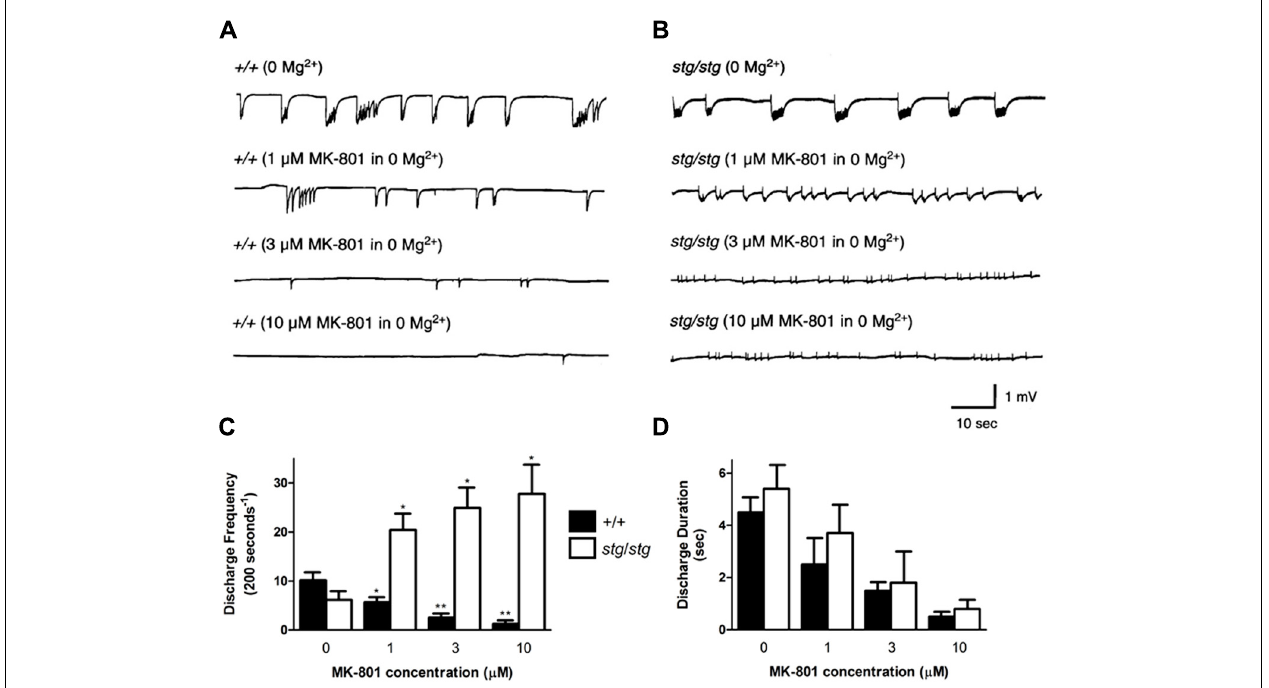
FIGURE 7 | Non-competitive NMDA receptor blockade with MK-801 also provokes paradoxical cortical network hyperexcitability in vitro . (A) In 0 Mg 2 + , discharges inWT cortex show a dose-dependent reduction in duration and frequency with application of MK-801. (B) In contrast, spontaneous 0 Mg 2 + -induced network bursting in stargazer cortical slices accelerates with